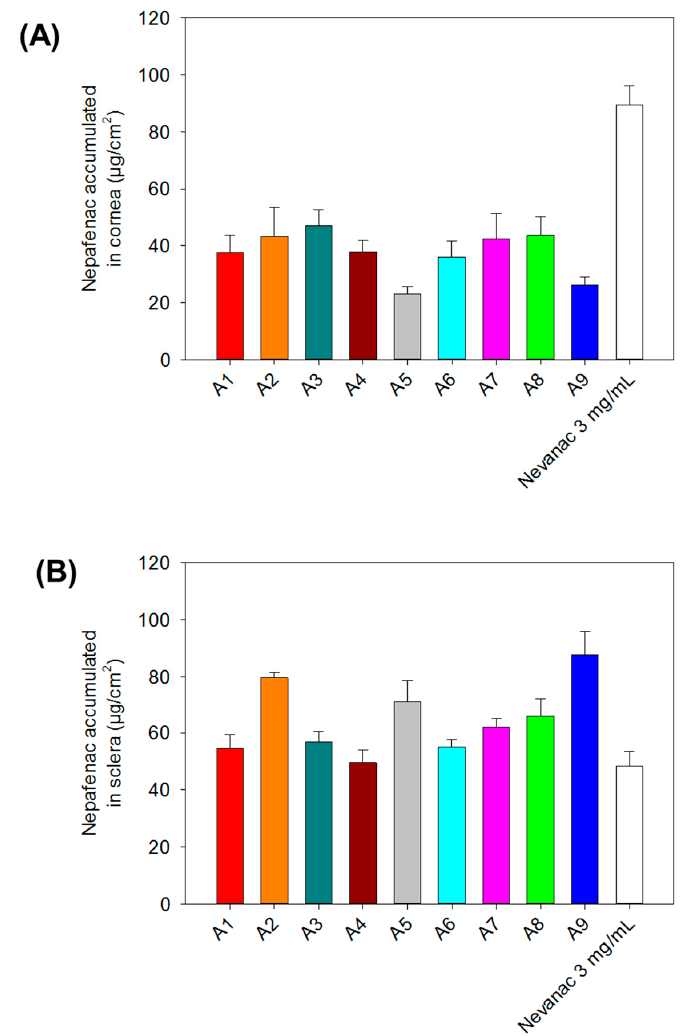
Figure 8. Nepafenac accumulated on the surface and inside ( A ) cornea and ( B ) sclera after six hours of exposure.